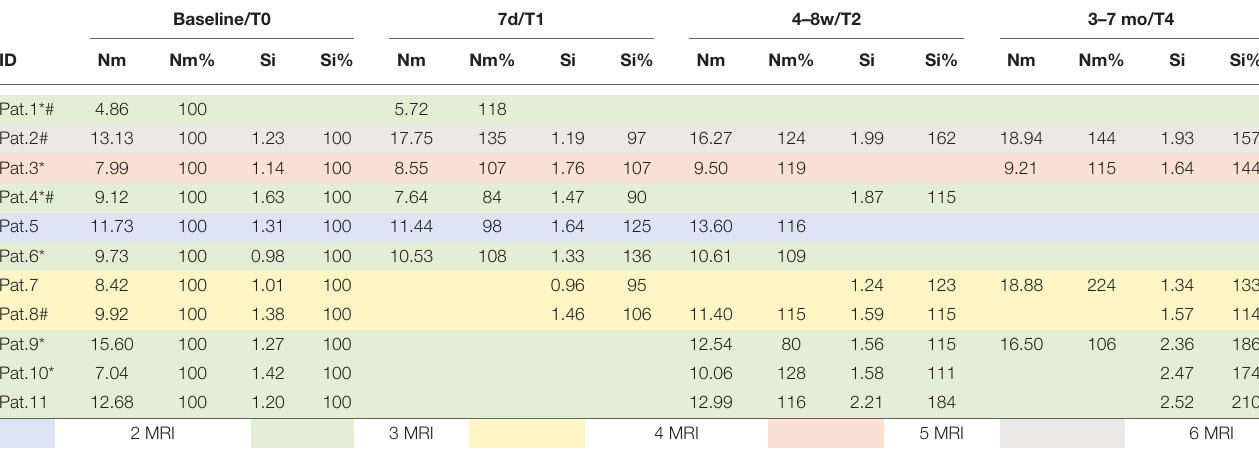
colors indicate different numbers of follow-up MRI examinations; patients marked with * were randomized to the exercise group; patients marked with # were pretreated with BNT. Si values refer to the quotient of the median value (Si) in the particular biceps edema zone divided by the median value (Si) in the corresponding area without edema in the biceps muscle. Nanometer